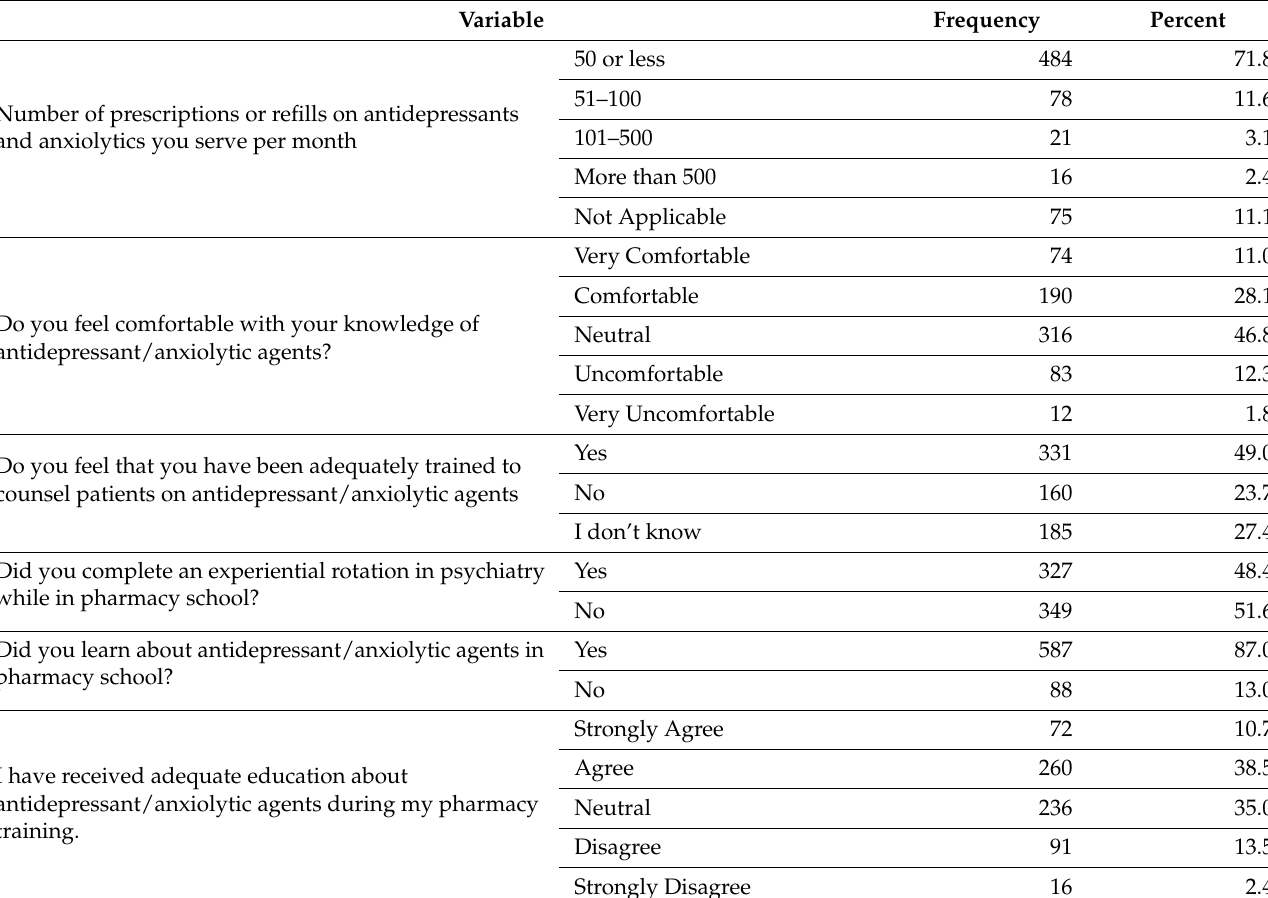
Table 2. Psychotherapeutics knowledge perception of respondent